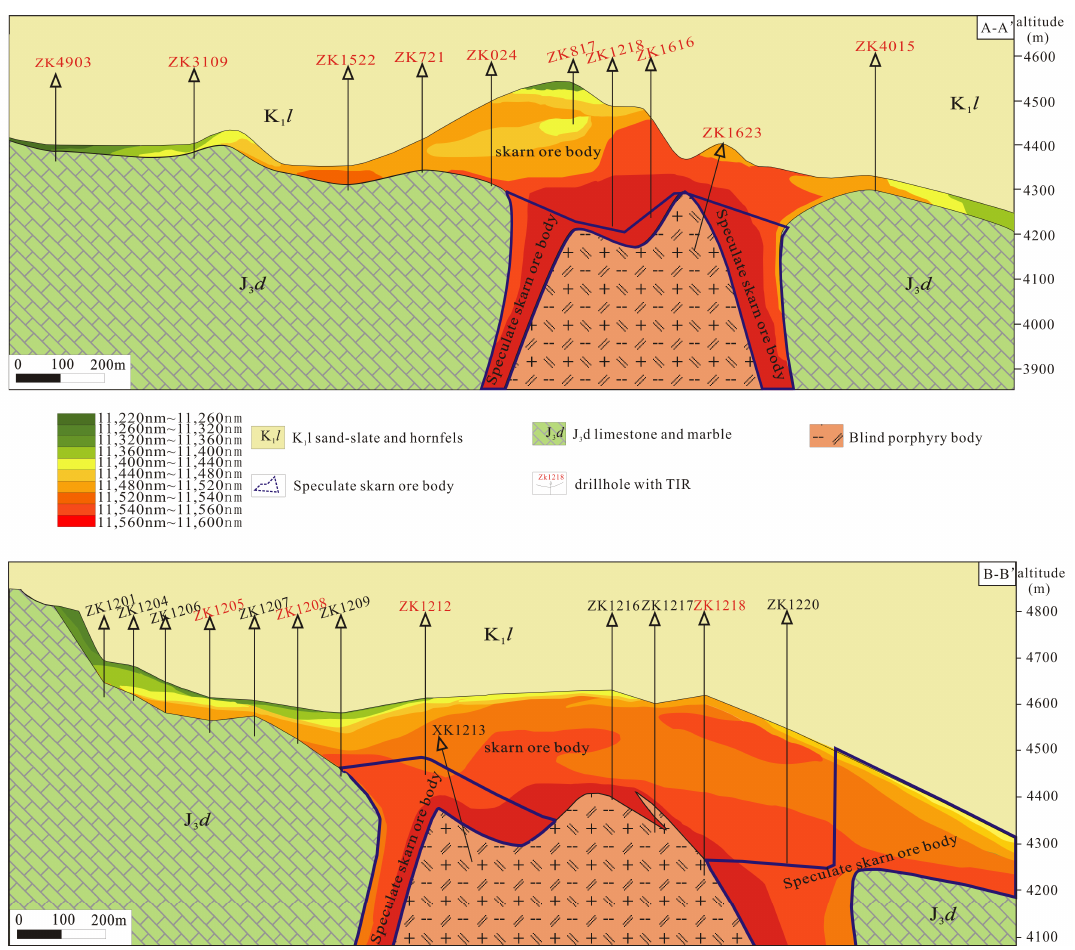
Figure 10. Spectrum mapping of garnet. A-A’ ( top ) et B-B’ ( bottom ). Table 4. EPMA analysis results (wt. %) and N FeGr of garnet.